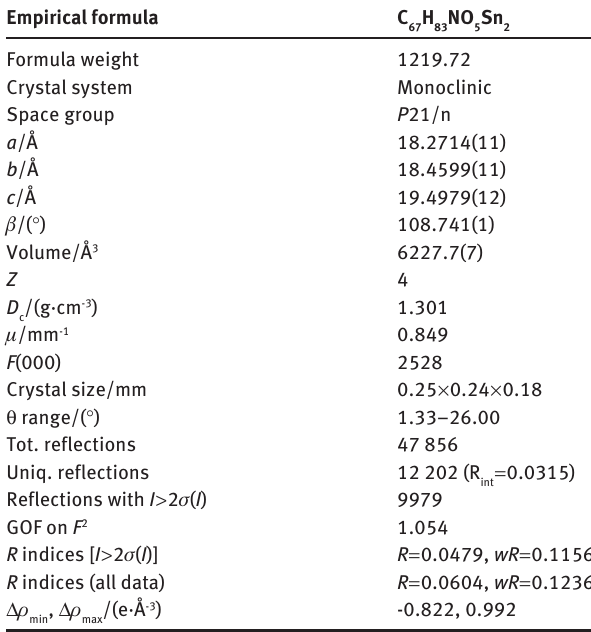
Table 3 Crystallographic and refinement data of 2 ·H